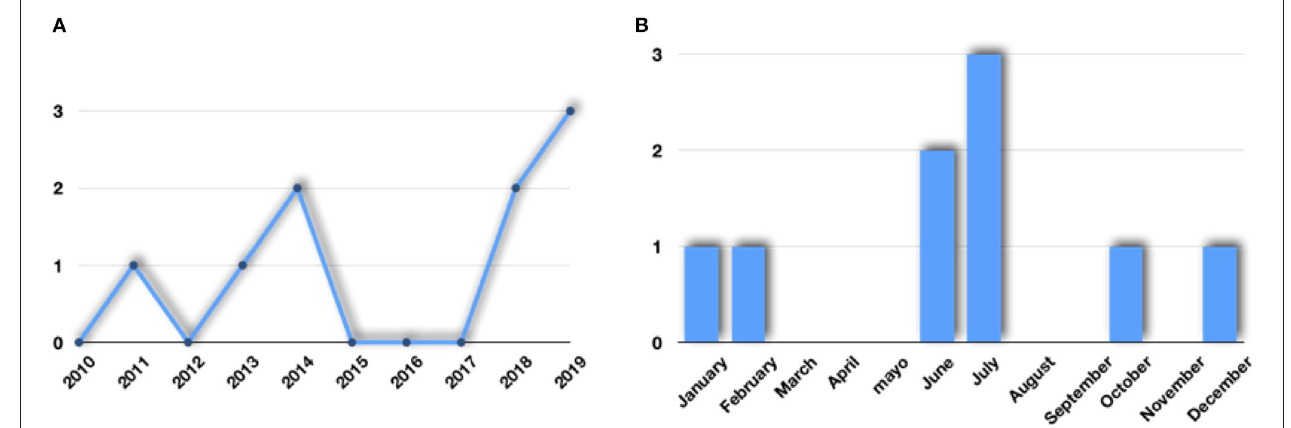
FIGURE 2 | Distribution of cases of S. suis infections reported in Catalonia 2010–2019 by year (A) and by month (B)